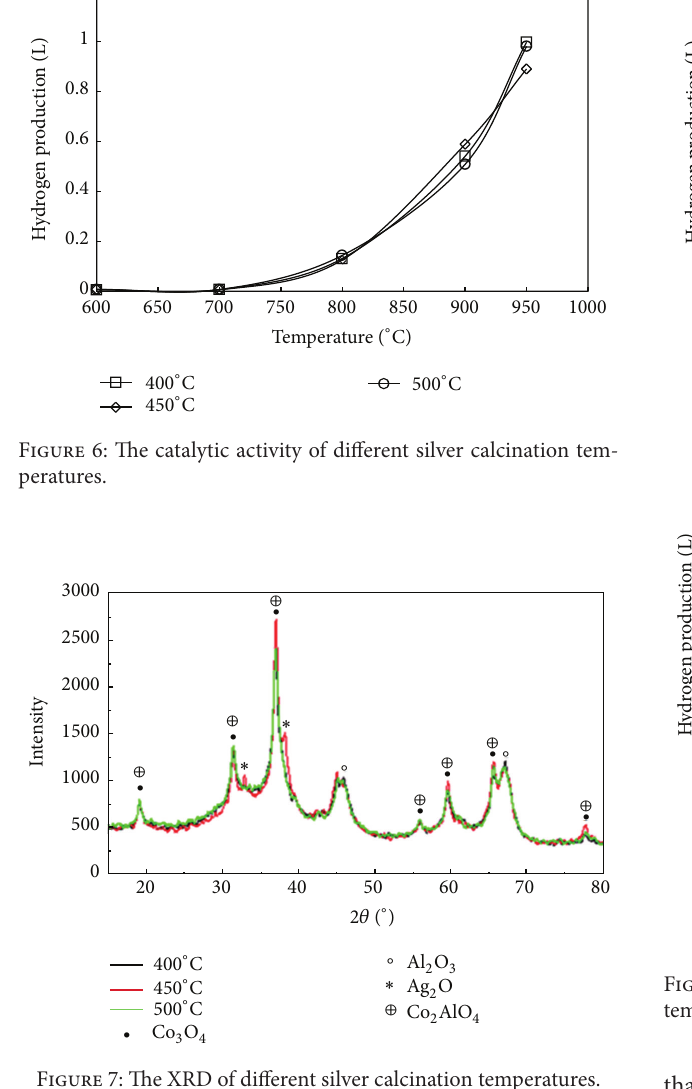
Figure 7: The XRD of different silver calcination temperatures.